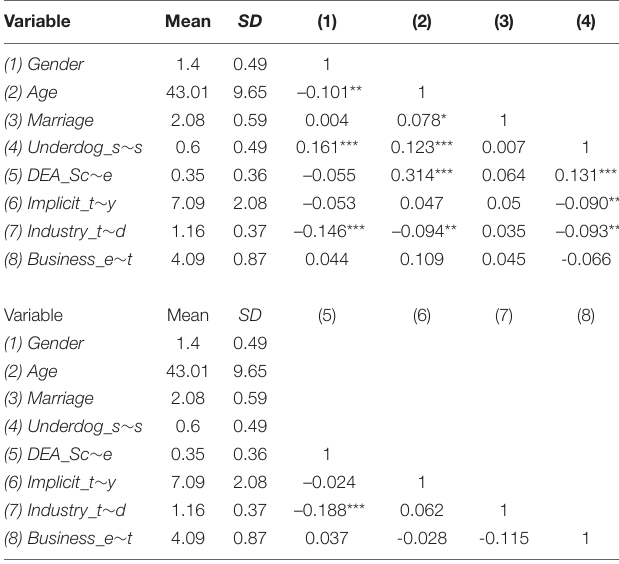
TABLE 2 | Descriptive statistics and correlation analysis.